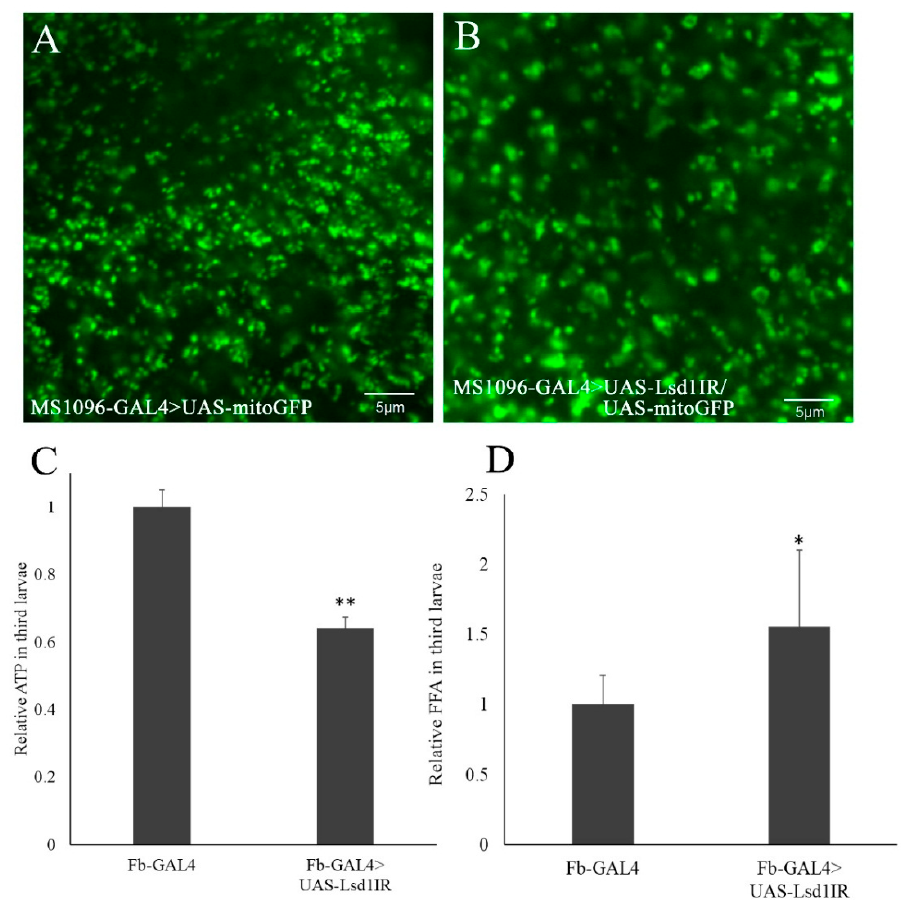
Figure 5. Knockdown of Lsd1 induces mitochondrial expansion and defects in ATP and free fatty acids (FFA) production. ( A , B ) The green fluorescent protein (GFP) signal expressed in mitochondria of wing disc cells were observed under BX-50 fluorescence microscopy. The control flies MS1096-GAL4/+; +; UAS-MitoGFP/+ (MS1096-GAL4 > UAS-MitoGFP) showed normal mitochondrial matrix ( A ); while the Lsd1 -knockdown flies MS1096-GAL4/+; UAS- Lsd1 IR/+; UAS-MitoGFP/+ (MS1096-GAL4 > UAS- Lsd1 IR/UAS-MitoGFP) appeared to exhibit mitochondrial expansion ( B ); Relative amounts of ATP ( C ) and FFA ( D ) of Lsd1 -knockdown flies yw ; Fb-GAL4/UAS- Lsd1 IR; + (Fb-GAL4 > UAS- Lsd1 IR). ATP and FFA amounts in whole bodies of third instar larvae were normalized to body weight. The experiments were repeated at least three times. * p < 0.05, ** p < 0.001, Student’s t test. The flies were reared at 25 °C.